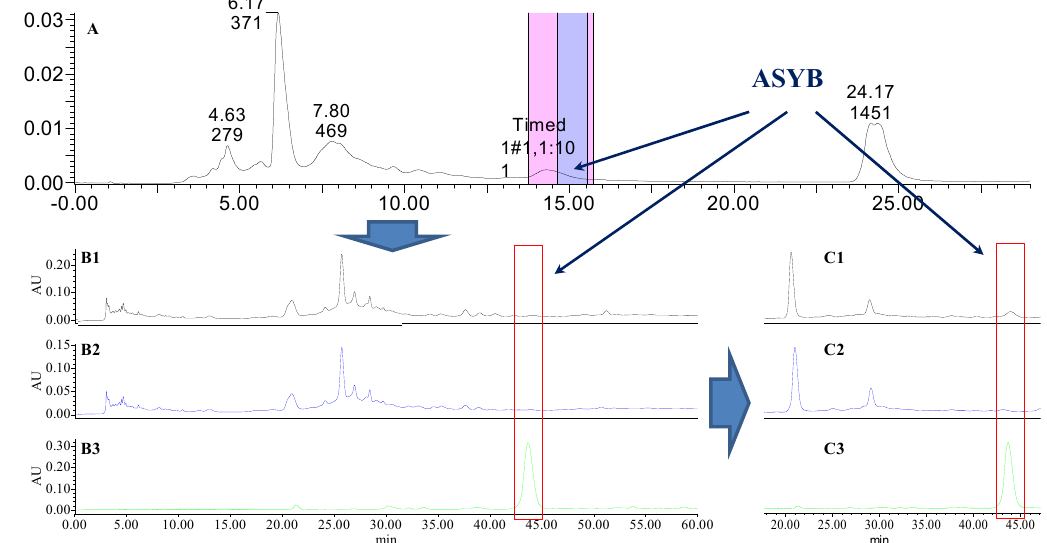
Figure 14. The preparative and analytical chromatograms of the depletion of ASYB from CF-SL. ( A ) preparative chromatogram at 270 nm; ( B1 ) analytical chromatogram of CF-SL at 270 nm; ( B2 ) analytical chromatogram of CF-SL-B at 270 nm; ( B3 ) analytical chromatogram of ASYB depleted from CF-SL at 270 nm. ( C1 ) analytical chromatogram of CF-SL at 400 nm; ( C2 ) analytical chromatogram of CF-SL-B at 400 nm; ( C3 ) analytical chromatogram of ASYB depleted from CF-SL at 400